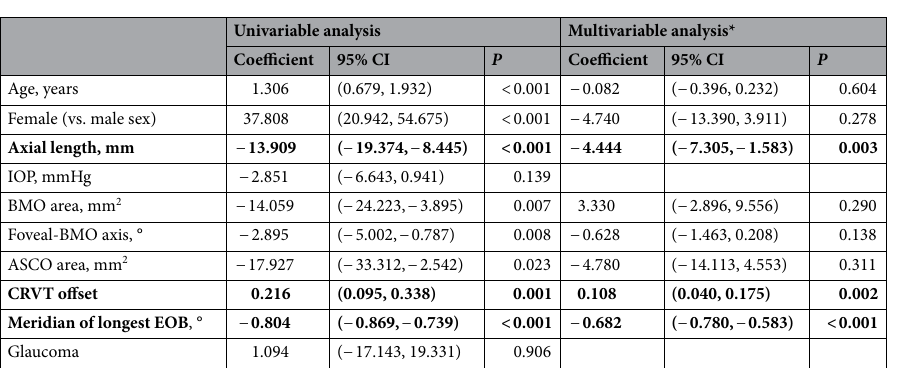
Table 3. Factors associated with angular deviation of anterior scleral opening (ASCO) offset. Statistically significant values ( P < 0.05) are shown in bold. CI, Confidence interval; IOP, Intraocular pressure; BMO, Bruch’s membrane opening; ASCO, Anterior scleral canal opening; CRVT, Central retinal vascular trunk; EOB, Externally oblique border. *Variables with P < 0.10 in the univariable analysis were included in the subsequent multivariable